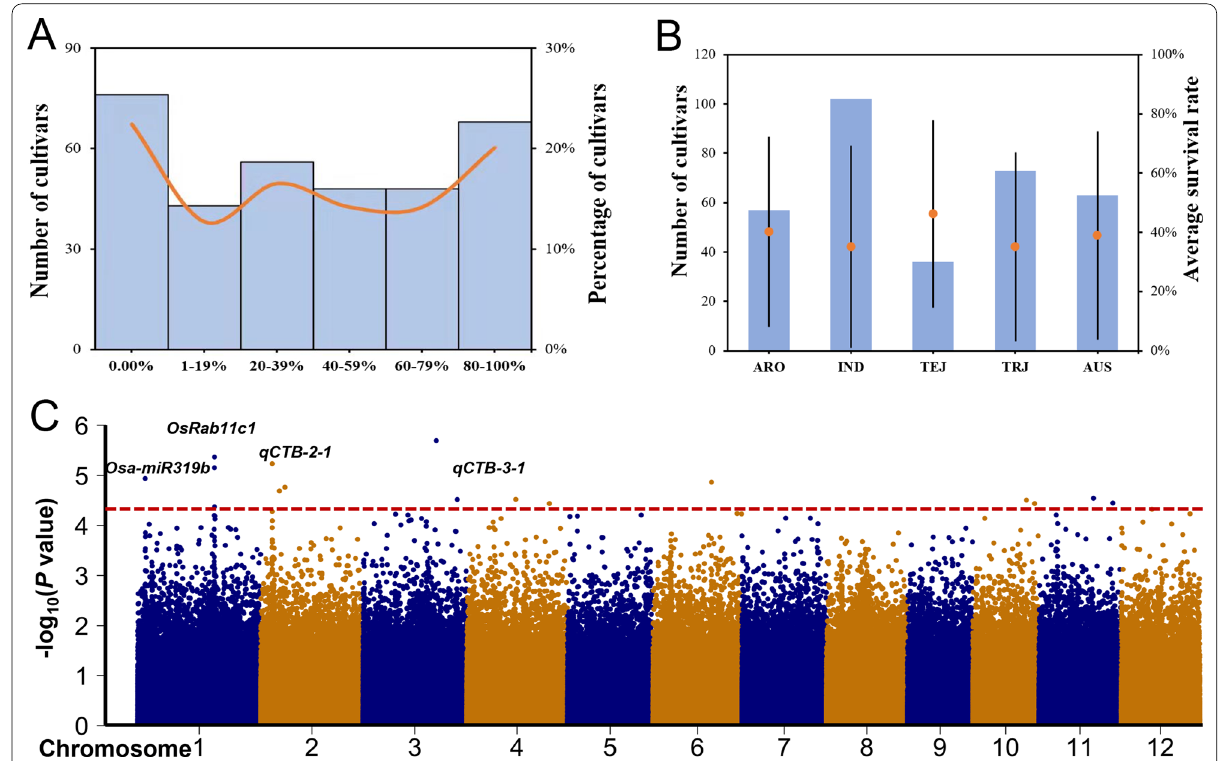
Fig. 1 Cold tolerance at the bud burst stage (CTB) of the RDP II population and GWAS of QTLs. A Distribution of the survival rate of 339 cultivars after cold treatment. The x‑axis shows survival rate and the y‑axis represents the number of cultivars. B Rice cultivars numbers (left y‑axis) of each subgroup (x‑axis) used in the study, and the average survival rate (right y‑axis) with error bars for each subgroup. C Manhattan plots of the association between SNPs and CTB phenotypes based on GWAS. The x‑axis shows the genomic coordinates and the y‑axis represents the LOD score for each